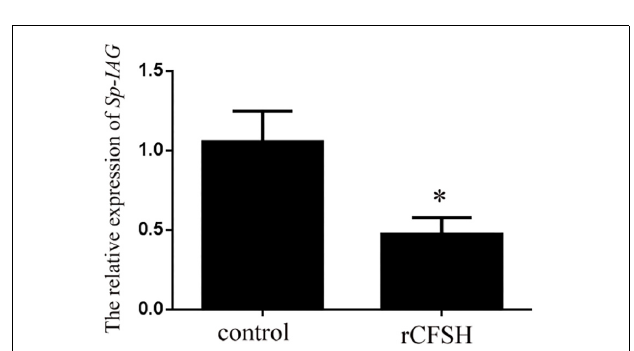
FIGURE 7 | Sp-IAG mRNA level in the AG explants after treatment with recombinant Sp-CFSH protein (rCFSH). Data are shown as means ± SEM of four separate repeats ( n = 4). Asterisks ( P < 0.05) on the top of the error bar indicates significant difference from the control